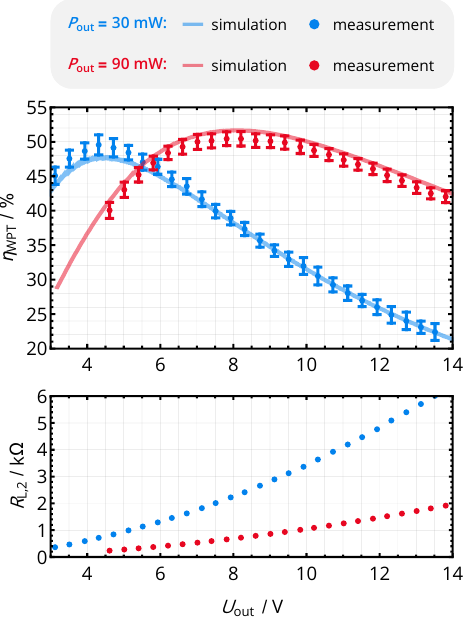
Figure 12. Overall system efficiency and effective DC load resistance versus the rectifier output voltage U out for constant load power levels P out . The coil separation distance was set to d 12 = 10mm ( M 12 = 46nH). The simulation values are obtained from a harmonic balance simulation using Keysight Advanced Design System 2016